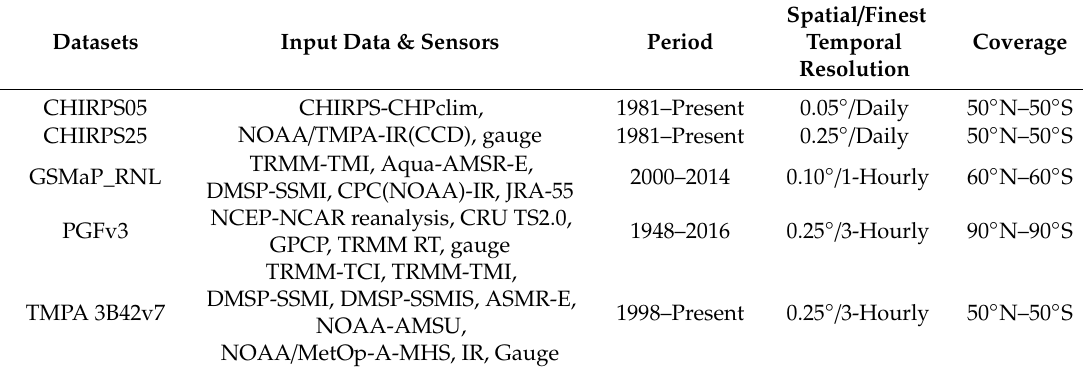
Table 1. Summary of five gridded precipitation products evaluated in this study including input data and related satellite